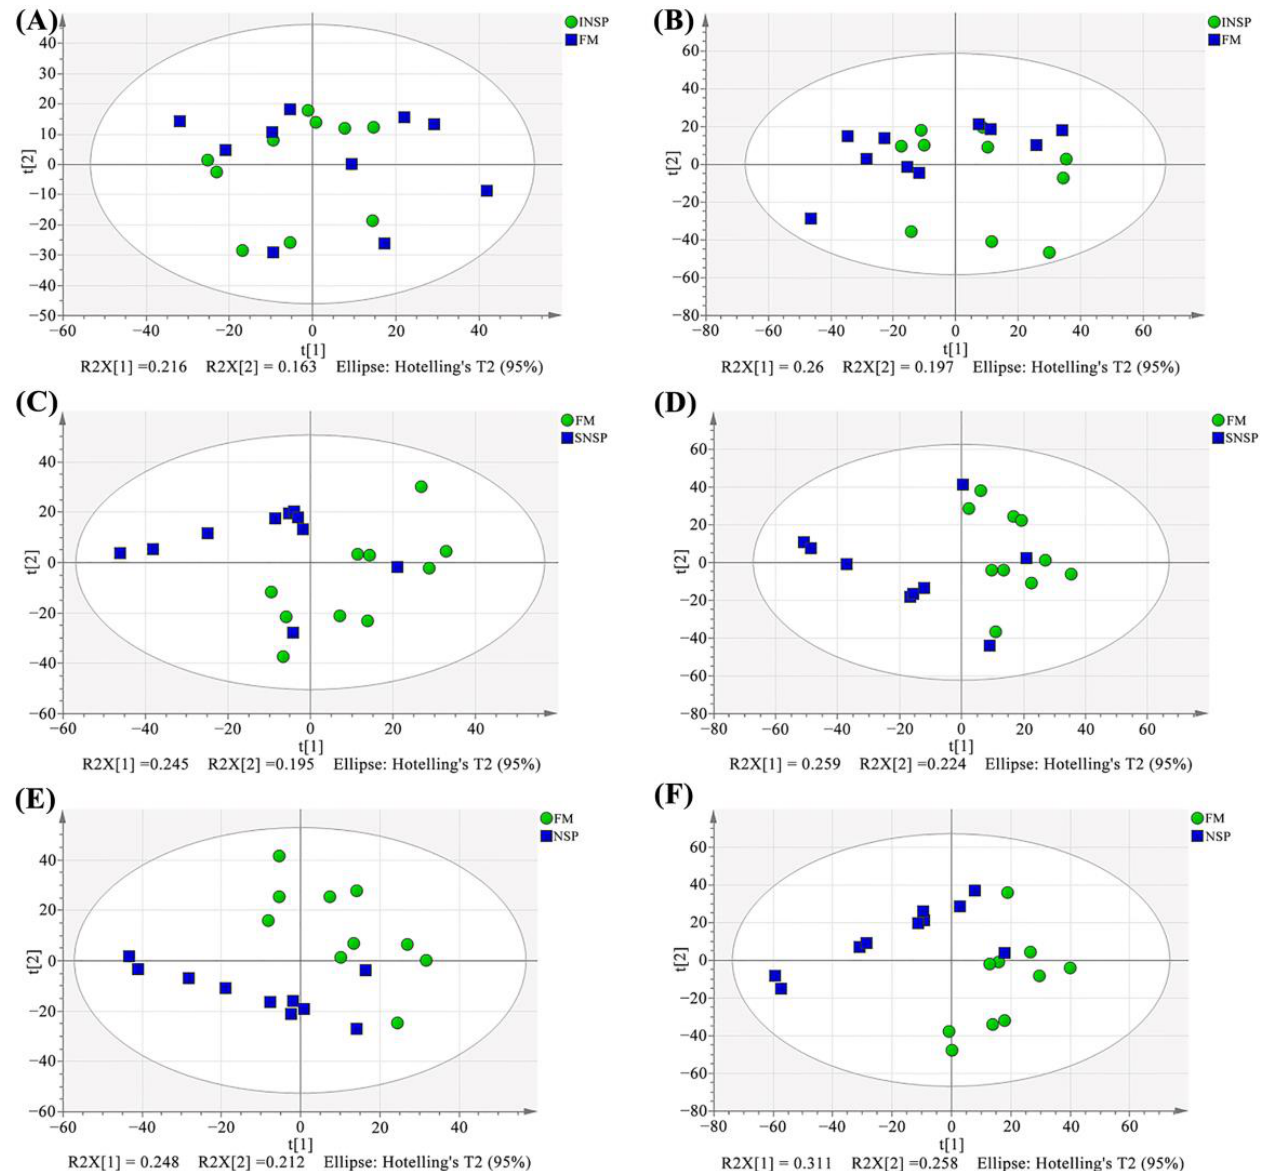
Figure 4. Serum metabolite profiles of PCA analysis results. ( A , B ) FM vs. INSP in positive and negative ion model, respectively; ( C , D ) FM vs. SNSP in positive and negative ion model, respectively; ( E , F ) FM vs. NSP in positive and negative ion model, respectively.